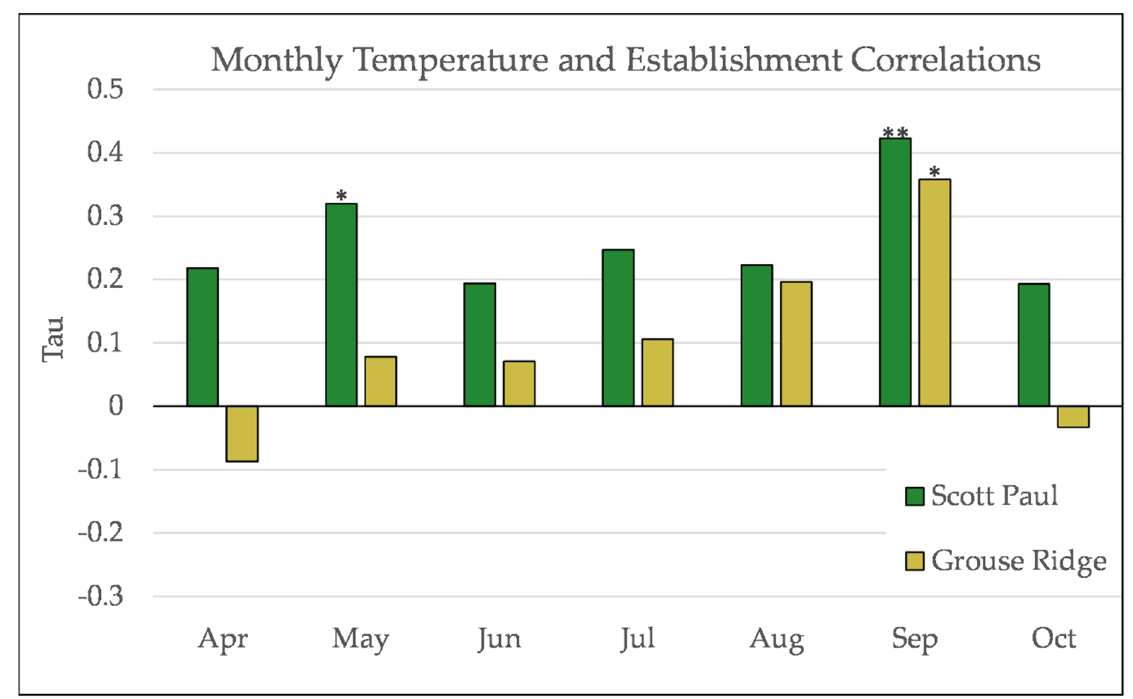
Figure 6. Partial Kendall’s correlation between mean monthly temperature and establishment at both sites. * = p -Value < 0.05, ** = p -Value < 0.01.